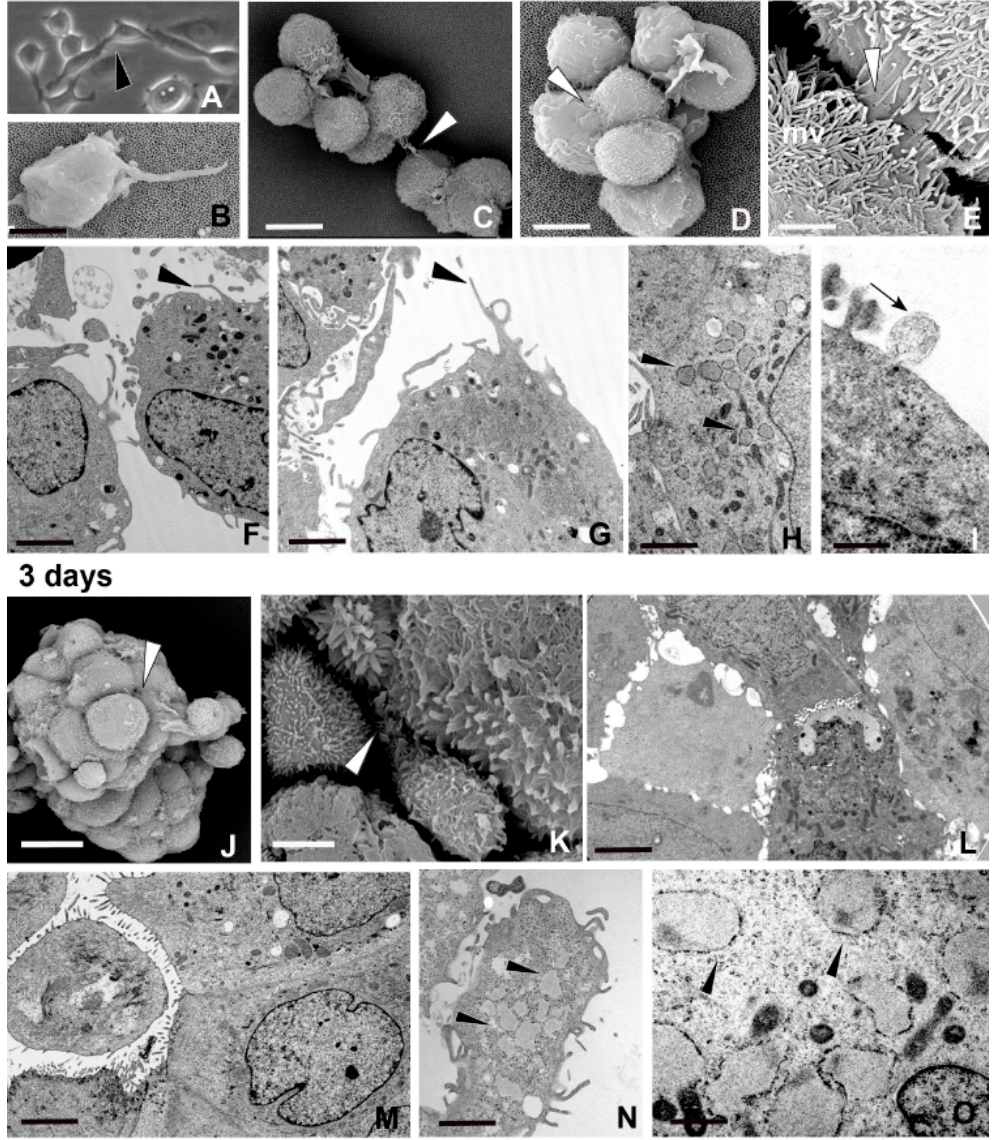
Figure 1. Morphology and behavior of cells during spheroid formation. ( A – I ) Twenty ‐ four hour spheroid culture. Phase ‐ contrast micrograph of free ‐ floating and of tiny aggregated human breast adenocarcinoma cells (MCF7) cells ( A ) showing projections among cells (arrowhead) and ultrastructural (scanning electron microscopy, SEM) detail ( B ) of tunneling nanotubes (TNTs) protruding from a single cell. Scale bar: 4.5 μ m. ( C – E ) SEM micrographs. The dimension of the aggregates is variable and the spatial organization of MCF7 cells is based on differing cell interactions. In smaller aggregate, few cells characterized by uniform dimension are in proximity ( C ) (white arrowhead), while in compacted ones, most of the cells are in close proximity or in contact ( D ) (white arrowhead), interacting ( E ) by short microvilli (mv) embedded in the dense amyloid matrix (white arrowhead). Scale bars: ( C ) 9 μ m; ( D ) 9.5 μ m; ( E ) 2 μ m. ( F , G ) Transmission electron microscopy (TEM) analysis. MCF7 cell surfaces are characterized by microvilli and by TNT ‐ like structures (arrowheads) reaching the neighboring cells. Scale bars: ( F ) 1.2 μ m; ( G ) 2 μ m. ( H , I ) TEM analysis. Cells are characterized by large dilated reticulum cisternae filled with spatially organized fibrillar material ( H ) (arrowheads) and released exosomes ( I ) (arrow). Scale bars: ( H ) 0.5 μ m; ( I ) 0.6 μ m. ( J – O ) Three day